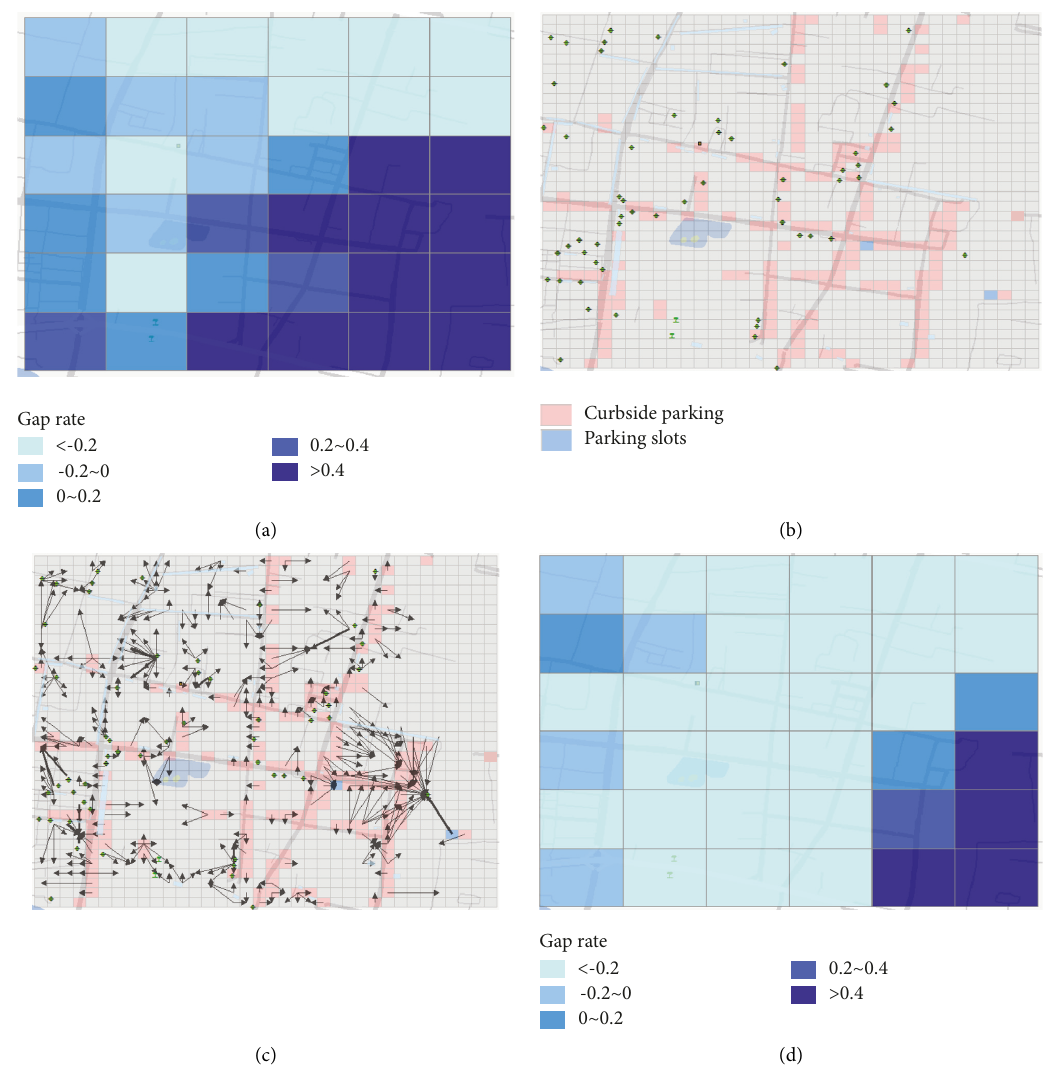
Figure 6: The optimization results of the parking resource allocation. (a) Existing imbalanced rate. (b) Optimal new facility location. (c) Vehicle-to-resource assignment. (d) Imbalanced rate after